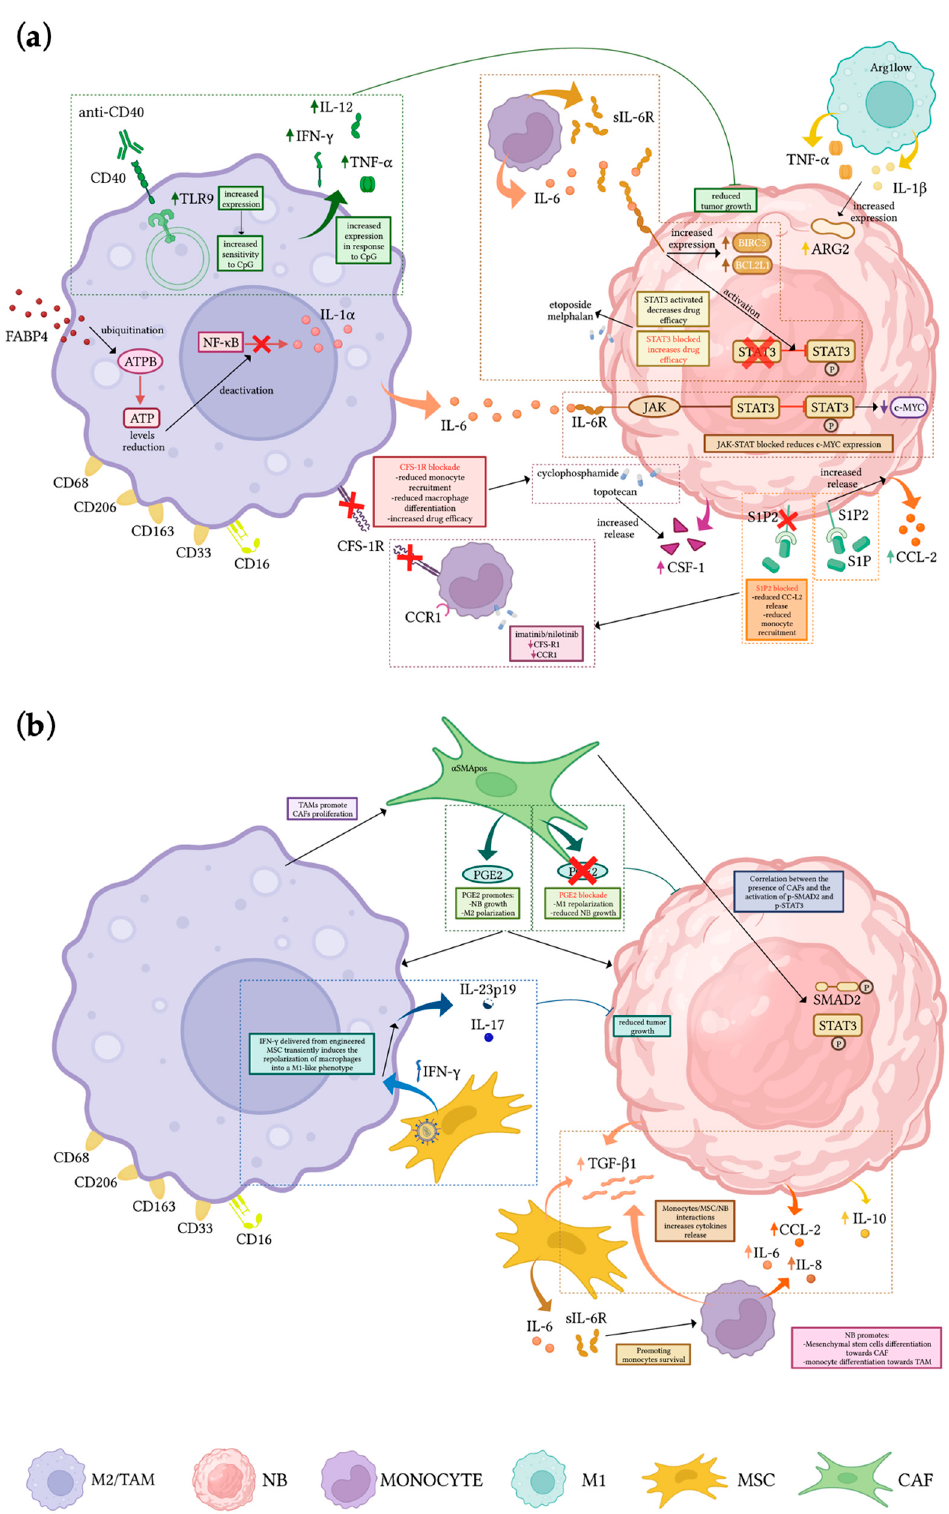
Figure 1. Cellular interactions in the NB microenvironment ( a , b ). Mechanisms of crosstalk among NB cells and macrophages/TAMs, monocytes, and stromal cells, and therapeutic strategies aimed at reducing tumor growth, reprogramming macrophage polarization, or reducing monocytes recruitment at the tumor site. Created with BioRender.com (accessed on 12 February